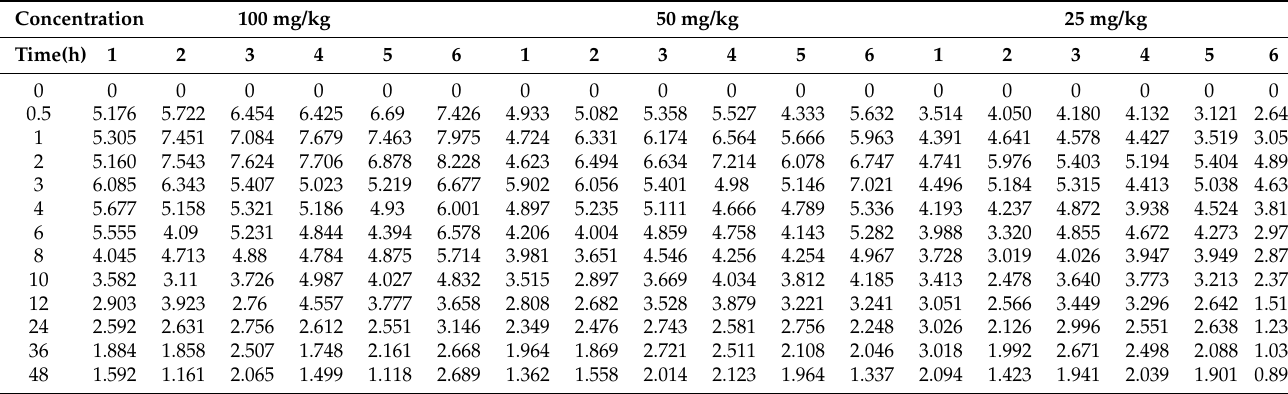
Table 4. Plasma concentration ( µ g/mL) of LBP-FITC after intragastric administration of LBP-FITC to rat at dosage of 100 mg/kg, 50 mg/kg, and 25 mg/kg ( n =